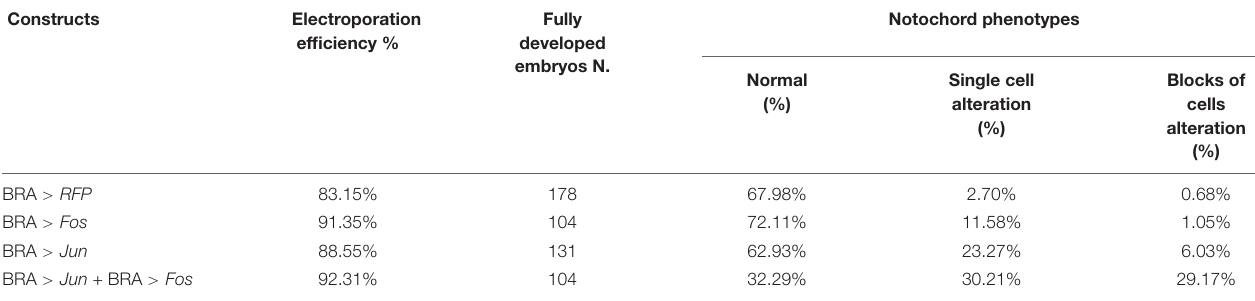
TABLE 2 | Percentages of notochord alterations observed in Bra > Jun and Bra > Fos transgenic embryos.